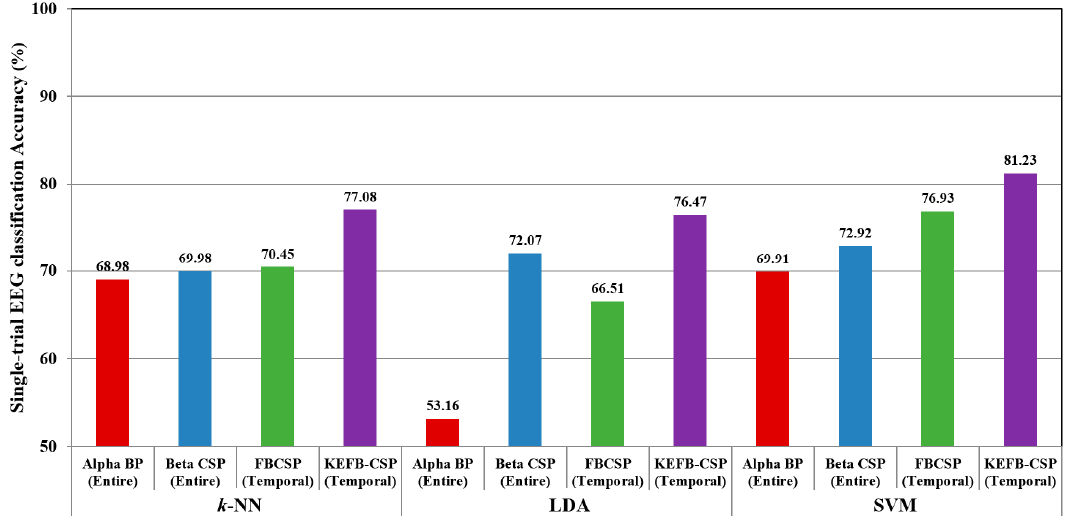
Figure 3. Comparison of average classification accuracies over 54-trial EEGs among different classifiers.